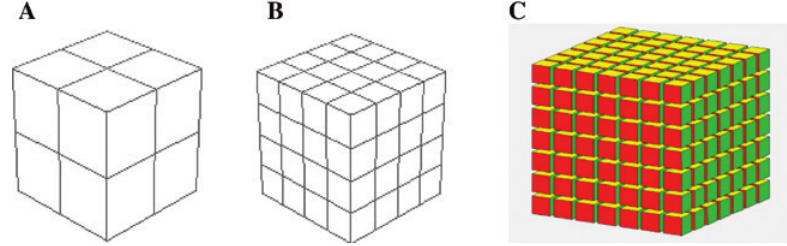
Figure 1: Representations of Voxels with Different Resolutions. (A) Low resolution; (B) medium-level resolution; (C) high